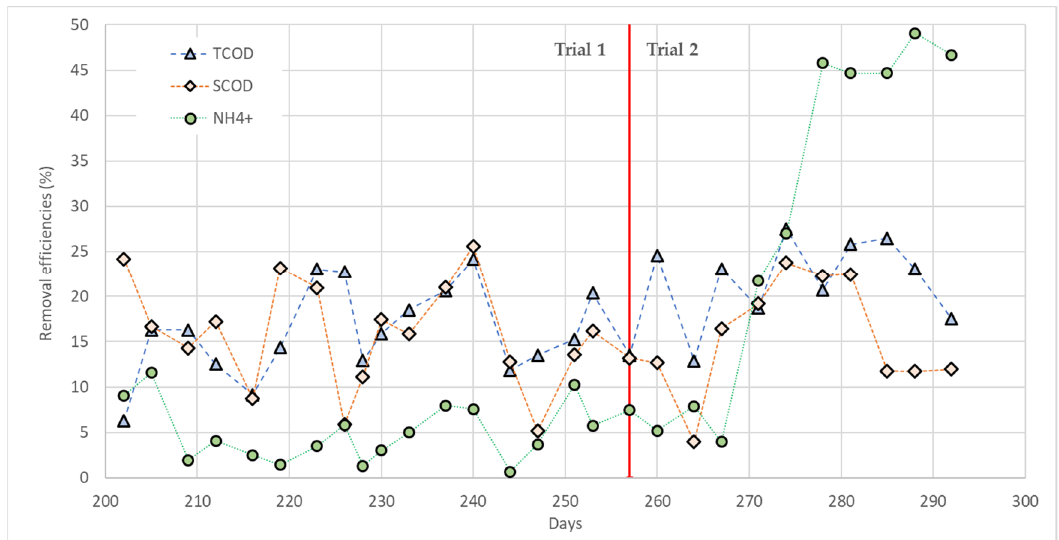
+ removal e ffi ciencies in the HyVAB Figure 9. TCOD, SCOD, and NH 4+ removal efficiencies in the HyVAB reactor. Figure 9. TCOD, SCOD, and NH 4